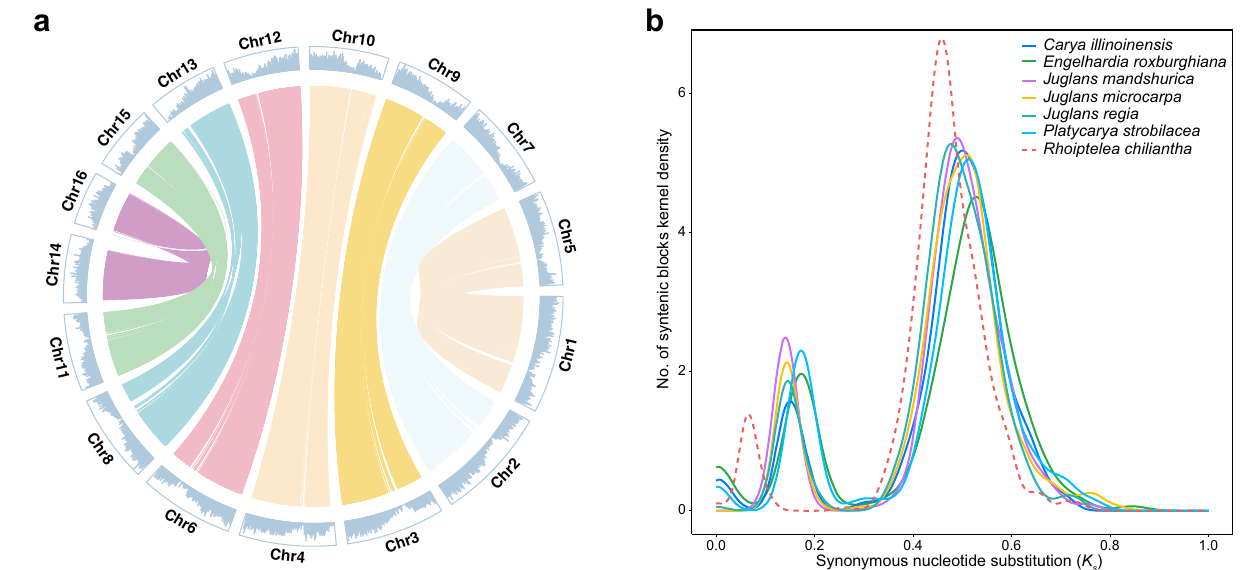
Fig. 2 | Whole-genome duplication detection. a A circular plot of Rhoiptelea chiliantha homoeologous chromosomes. The reciprocal-best-hits homologous gene pairs were used in MCScanX. Central lines connect collinear blocks across chromosomes,onwhichgenedensityisshown.Differentcolorsrepresentdifferent